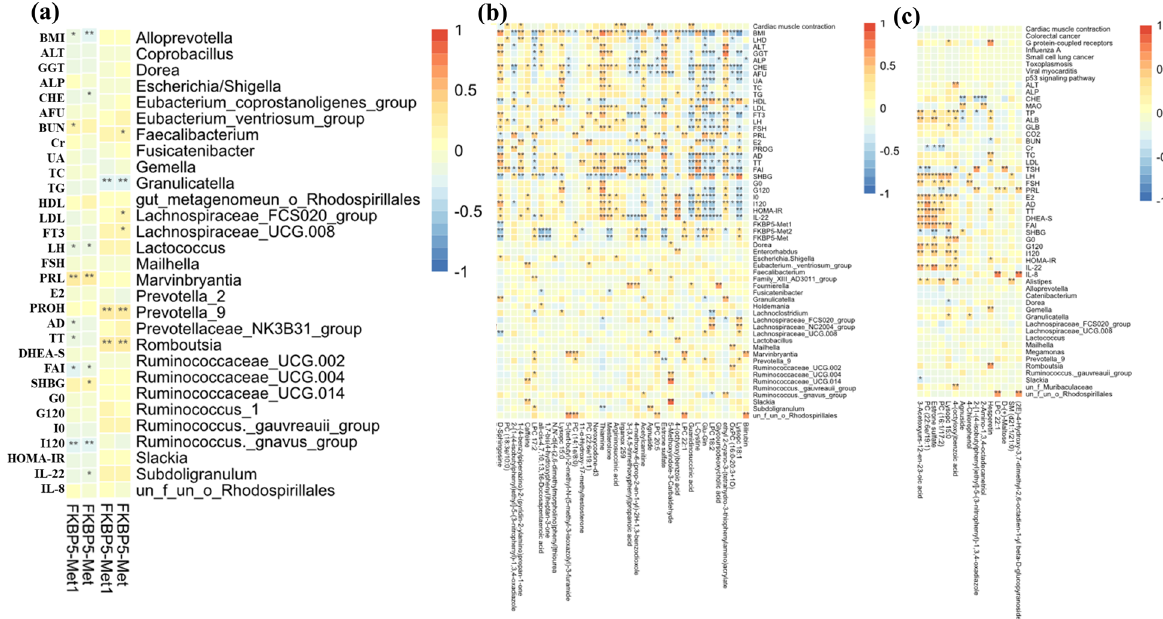
Fig. 5 Clinical characteristics correlate with bacterium and pathways. In the heat map, * p < 0.05 denotes signi fi cant correlations between pairs. a DNA methylation correlation with clinical indices and bacterial taxa. b Correlation between metabolites and other factors screened from comparison between healthy patients and patients with PCOS-HB. c Correlation between metabolites and other factors screened from comparison between healthy patients and patients with PCOS-LB. PCOS-LB, normal BMI (BMI < 24); PCOS-HB, high BMI (BMI ≥